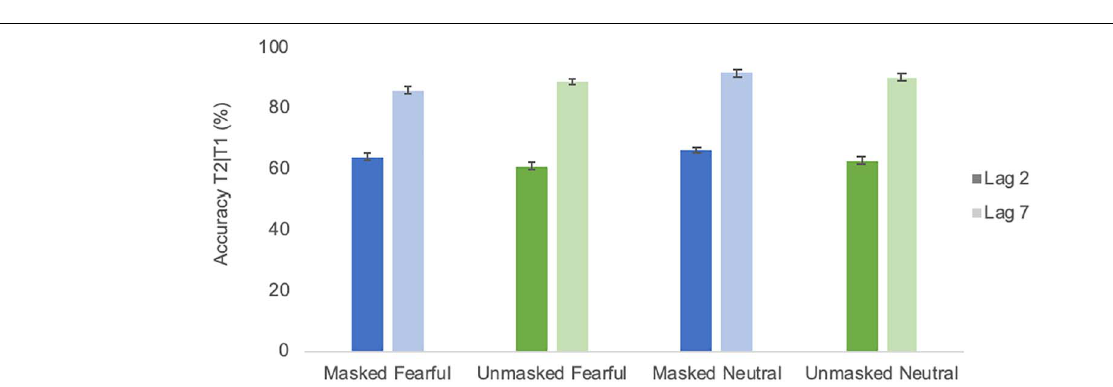
FIGURE 3 | Average identification accuracy of T2 in different emotional conditions of Experiment 1. Error bars represent one standard error of the